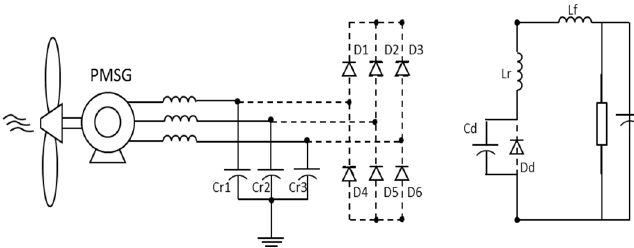
Figure 14. Sixth stage: Equivalent circuit.